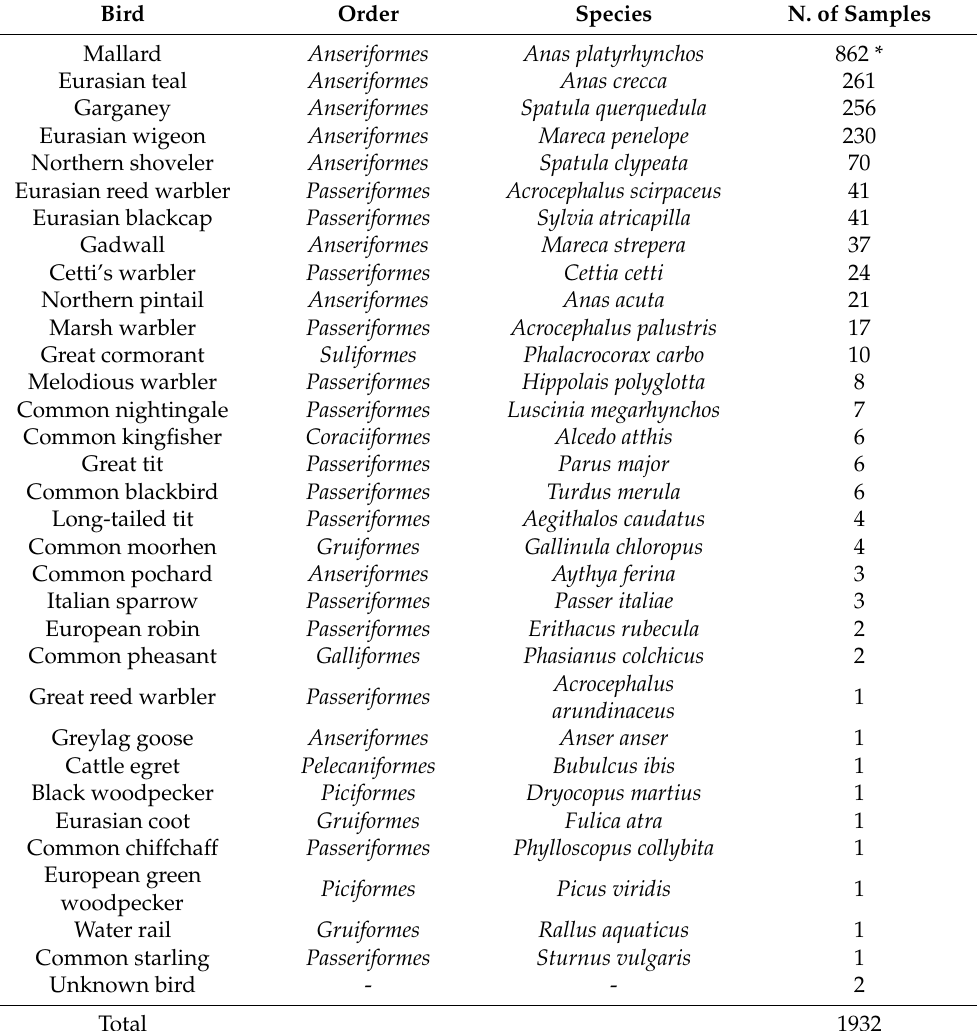
Table 2. Number of sampled wild birds and relative